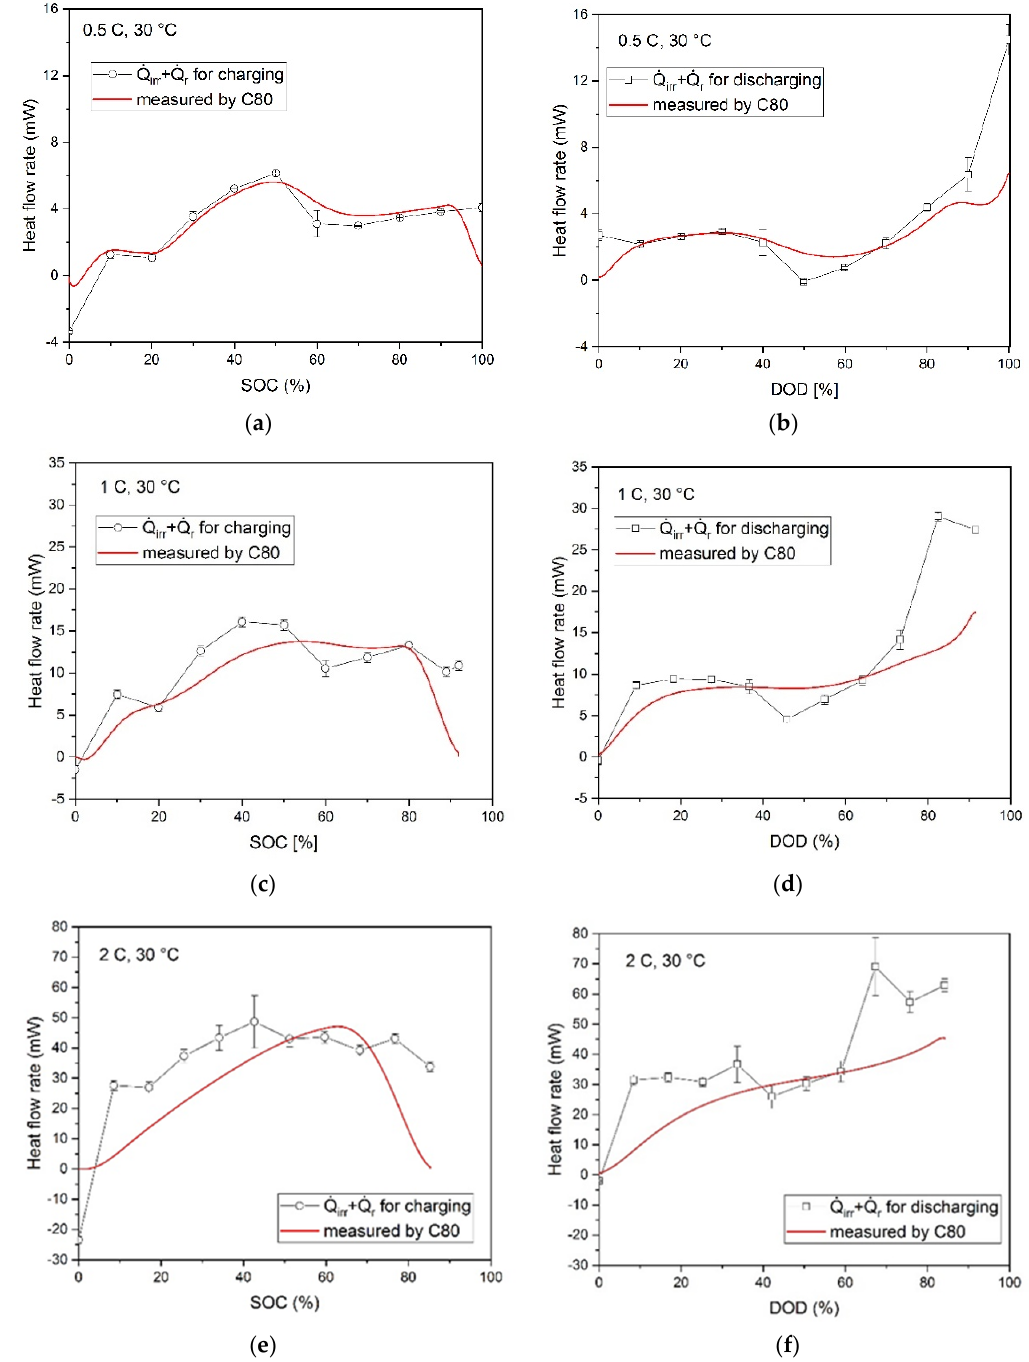
Figure 9. Comparison of calculated heat flow rates versus SOC/DOD under different C-rates and heat flow rates measured by C80 calorimeter: ( a ) charging with 0.5 C; ( b ) discharging with 0.5 C; ( c ) charging with 1 C; ( d ) discharging with 1 C; ( e ) charging with 2 C; ( f ) discharging with 2 C. The total amount of the generated heat measured in the calorimeter (C80) compared to the contribution of the irreversible Q irr and the reversible part Q r is shown in Figure 10. At the highest C rate, the deviations of the calculated from the measured results for charging and discharging process, respectively, are both reaching minimum values. The deviation for all C-rates falls into the range of +/− 5%.